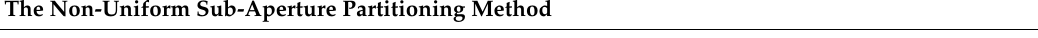
Table 1. The steps for the non-uniform sub-aperture partitioning method. The Non-Uniform Sub-Aperture Partitioning